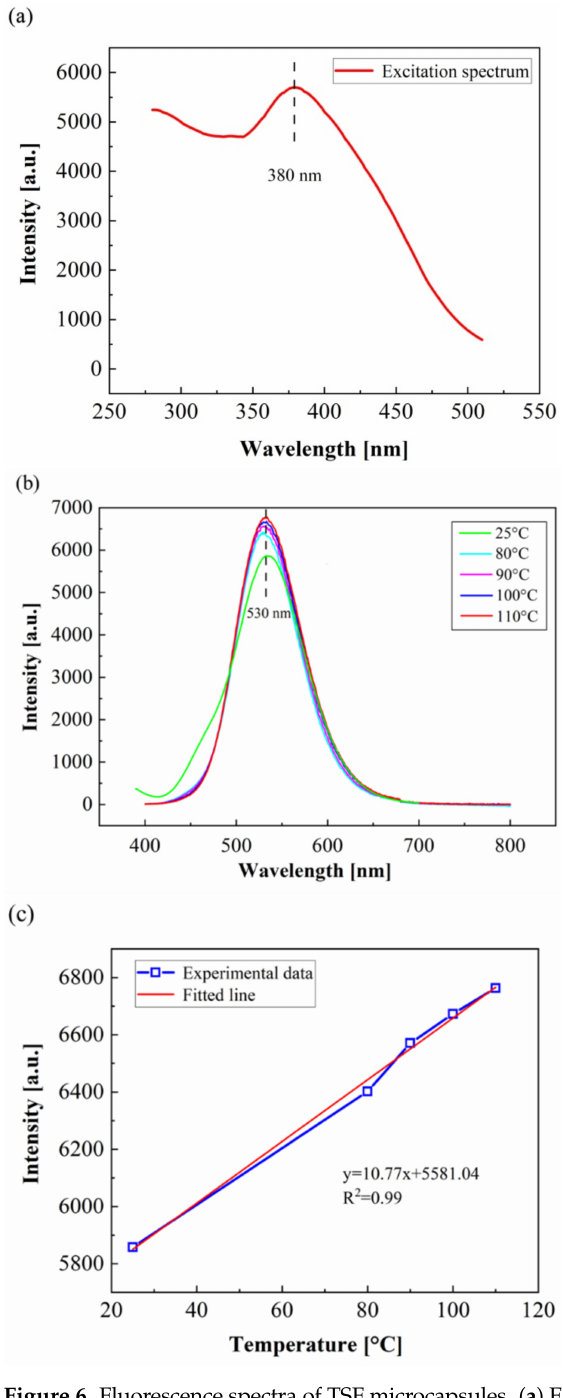
Figure 6. Fluorescence spectra of TSF microcapsules. ( a ) Excitation spectrum, ( b ) variable temperature fluorescence emission spectrum, ( c ) the strongest fluorescence intensity value at different